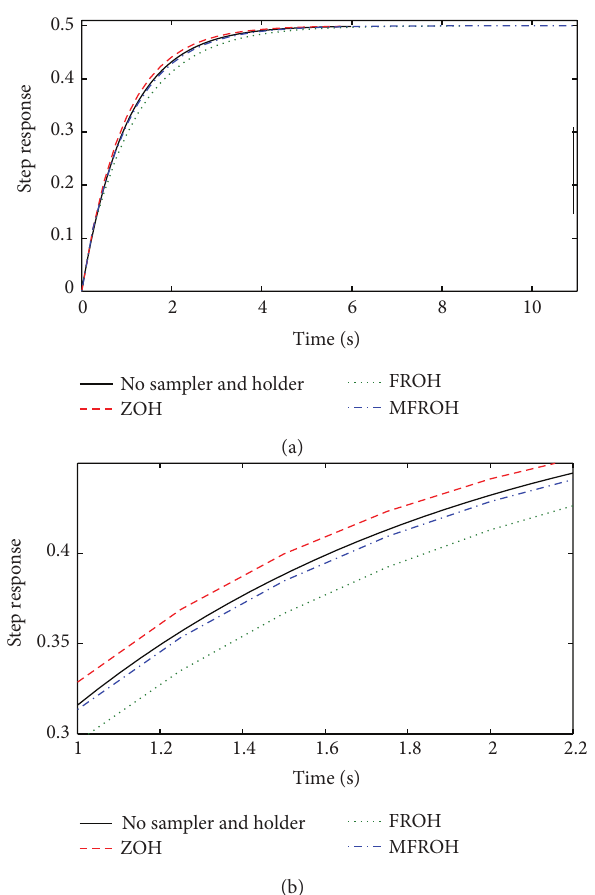
Figure 9: (a) Step response of the closed-loop continuous system and digital control system when using MFROH, FROH, and ZOH. (b) Focusing on the step response to show the effect of different